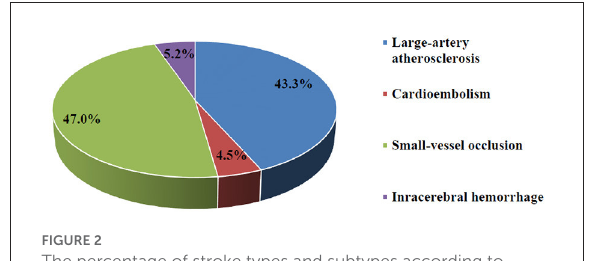
FIGURE2 The percentage of stroke types and subtypes according to TOAST classification.